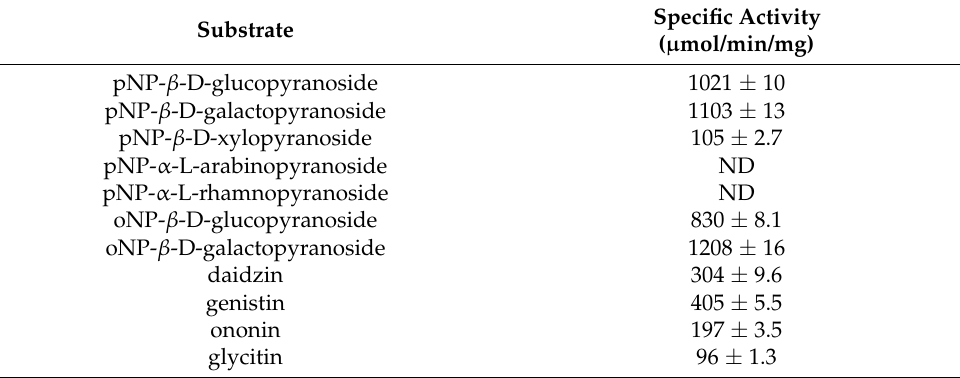
Table 1. Substrate specificity of β -galactosidase from T. Uuzoniensis a